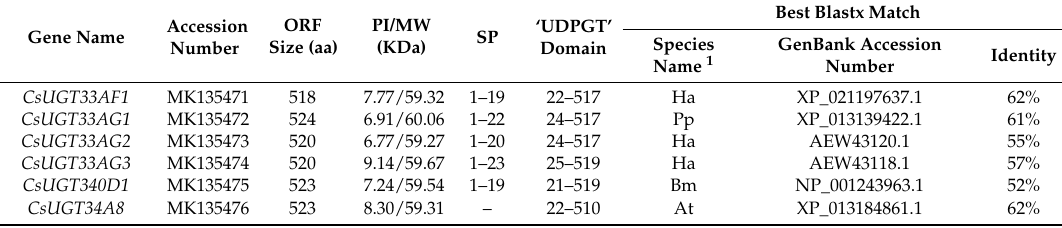
Table 2. Characteristics of the UGT genes identified in C. suppressalis